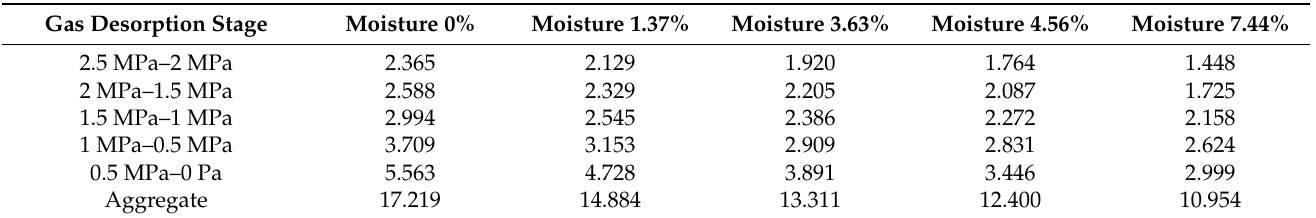
Table 3. Gas desorption capacity in different stages of depressurization and desorption with different moisture